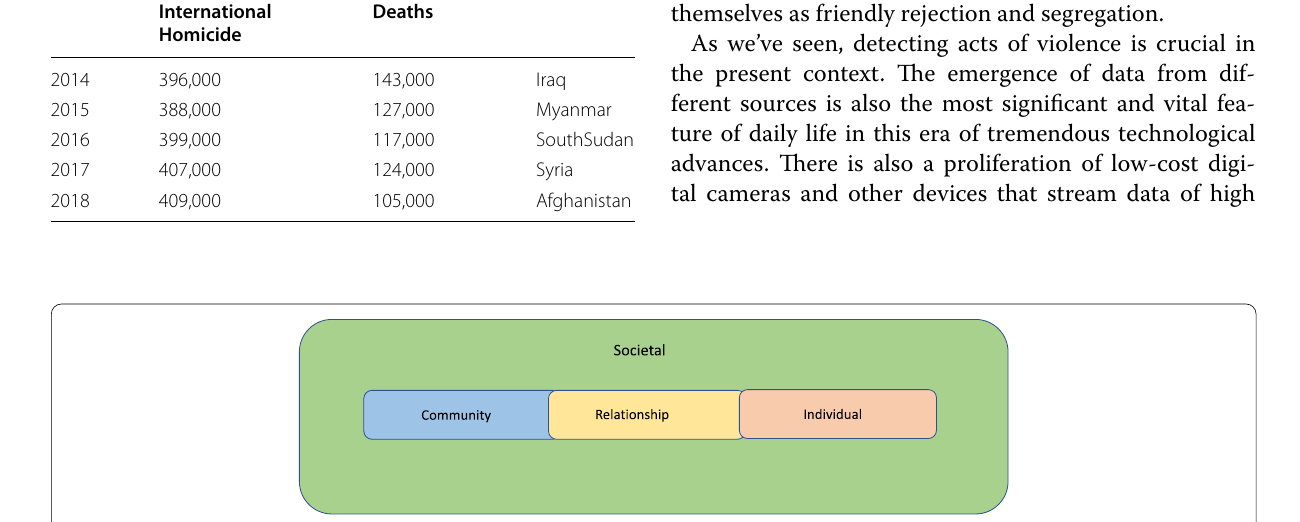
Fig. 2 Ecological